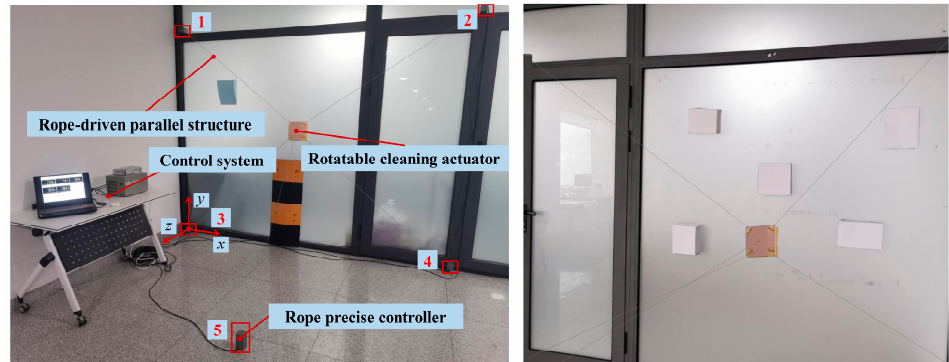
Figure 13. Experimental platform.